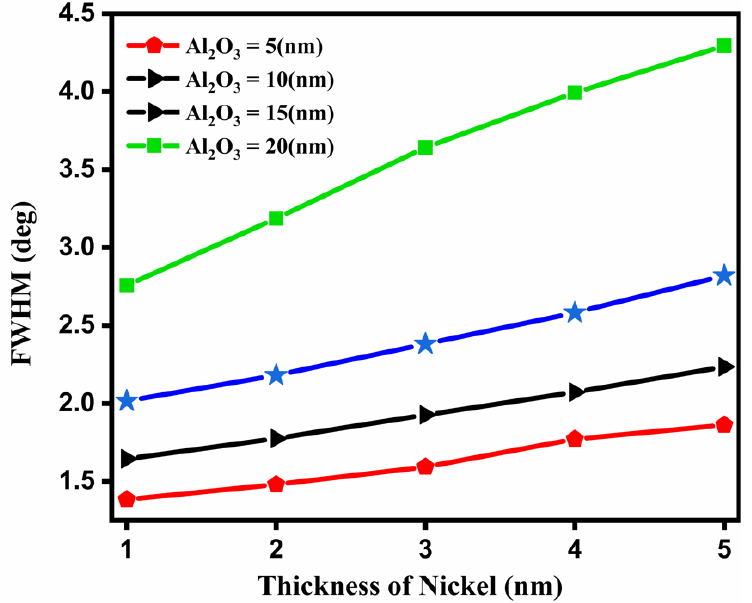
Figure 5. Variation of thickness of Ni vs. FWHM.